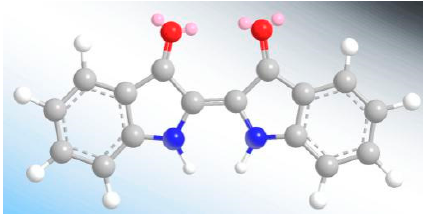
Figure 1. 3D molecular structure of indigo.